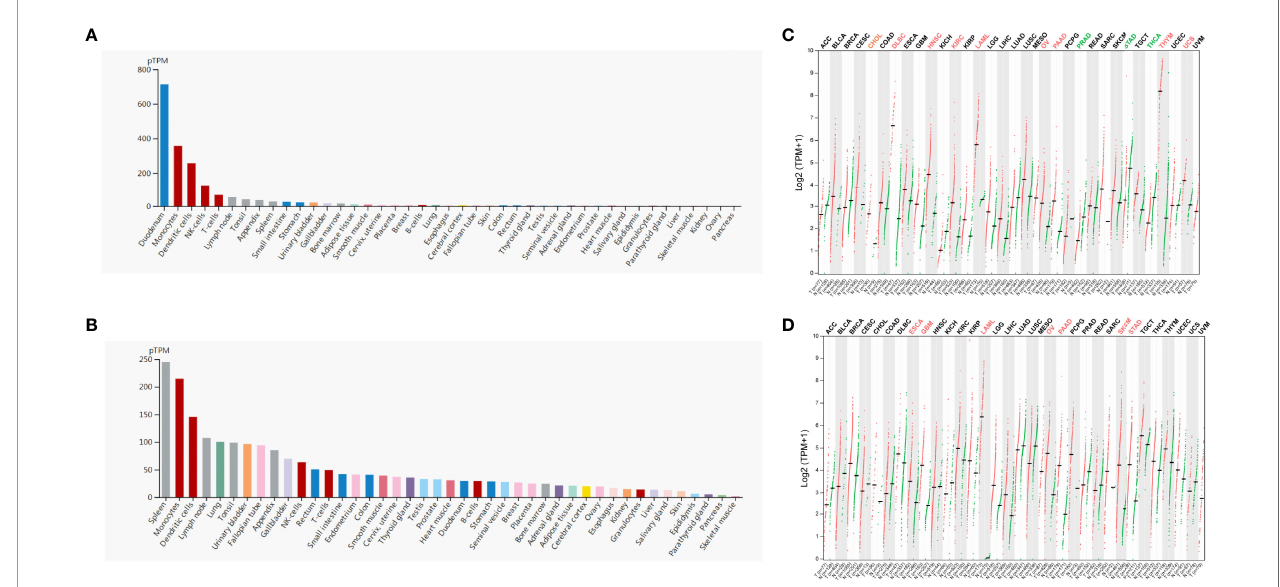
FIGURE 1 | ADA1 and ADA2 expression pro fi les in human tissues. (A, B) HPA database showed the ADA1 and ADA2 expression in normal human tissues. (C, D) Comparisons of ADA1 and ADA2 expression levels between tumor and non-tumor control tissues based on TCGA and GTEx database (black, expression levels showed no signi fi cant difference between tumor and normal; red, expression levels were increased in tumor; green, expression levels were decreased in tumor). HPA, Human Protein Atlas; TCGA, The Cancer Genome Atlas; GTEx, Genotype-Tissue